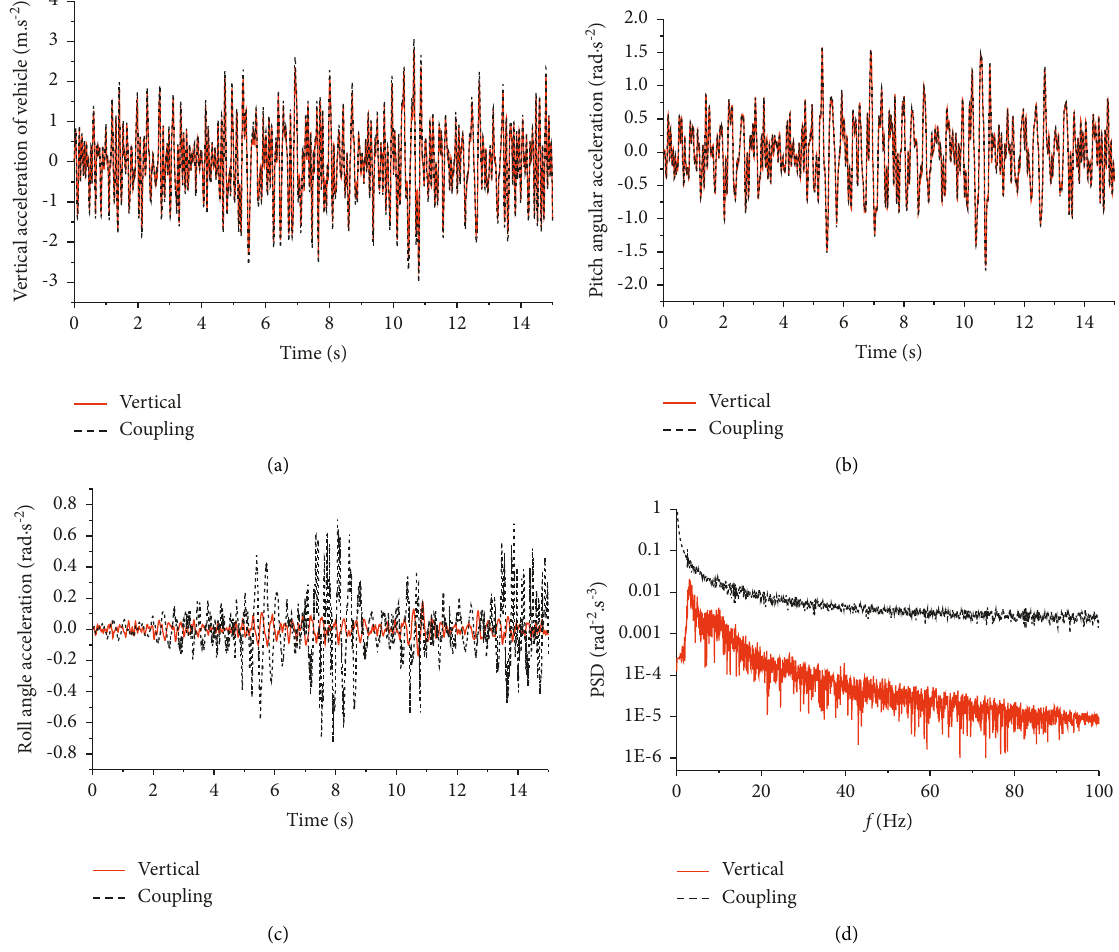
Figure 6: Ride comfort response (serpentine working condition, B-level random road). (a) Vertical acceleration of vehicle. (b) Pitching angular acceleration. (c) Roll angle acceleration time domain. (d) Roll angle acceleration frequency